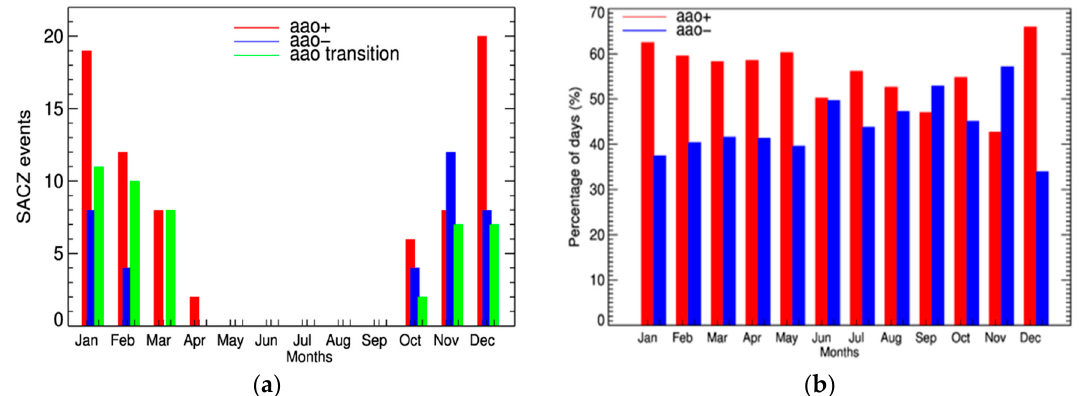
Figure 2. ( a ) Monthly frequency of the number of SACZ events in each phase of AAO and in AAO transition periods and ( b ) the percentage (%) of days in each phase of AAO, both for the period 1992–2015. The red bars are for AAO+, the blue bars for AAO– and green bars for AAO transition periods.